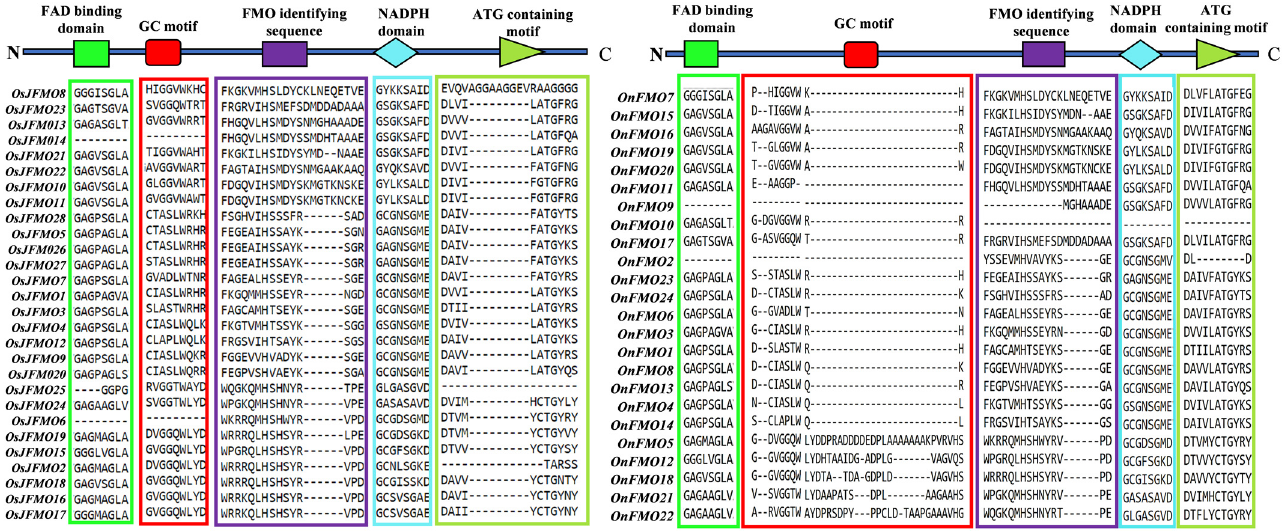
Figure 3. Schematic representation of the conserved FMO-identifying motifs in the FMO proteins in wild and cultivated rice. FMO-identifying motifs previously reported in literature were searched for in the FMO protein sequences of the cultivated Oryza sativa subsp. japonica and wild species, Oryza nivara. The motif sequences have been marked by colours representing each of the conserved motifs, bright green: FAD binding domain; red: GC motif, violet: FMO-identifying sequence; cyan: NADPH domain and light olive green: ATG-containing motif.